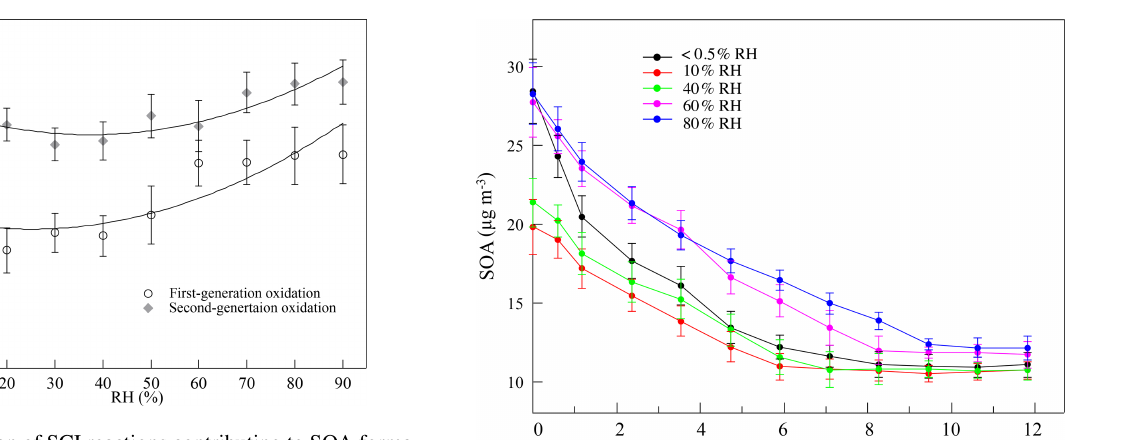
Figure 4. The fraction of SCI reactions contributing to SOA forma- tion in the (a) first- and (b) second-generation oxidation at different relative humidity (RH) levels. Figure 5. The variation in SOA mass concentration (SOA) with the concentration of acetic acid ([AA]) at different relative humidity (RH) levels in the first-generation